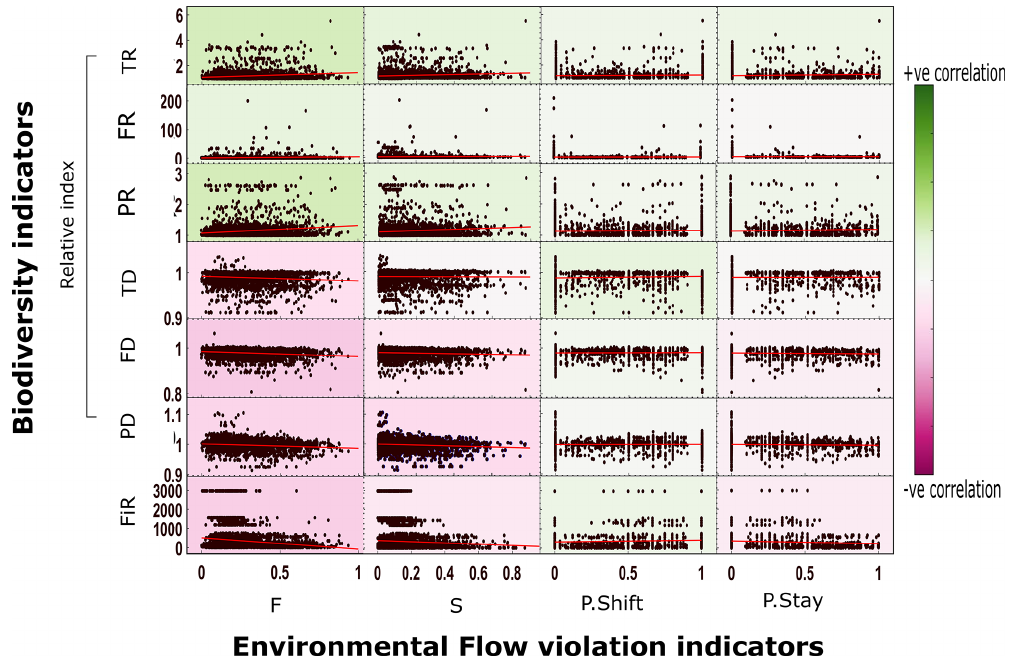
Figure 3. Scatter between EF violation indices and biodiversity indices (plots include linear fits) at a globally aggregated scale. Note: this figure represents results from case 1 (level 5 HydroBASIN matched with biodiversity data). The results of other aggregation methods are given in the Supplement (Figs. S5 and S6). Abbreviations: F – frequency of violation; S – severity of violation; P.shift – probability of shifting to a violated state; P.stay – probability of staying in a violated state; FiR – fish richness; TR – taxonomic richness; FR – functional richness; PR – phylogenetic richness; TD – taxonomic dissimilarity; FD – functional dissimilarity; PD – phylogenetic dissimilarity.